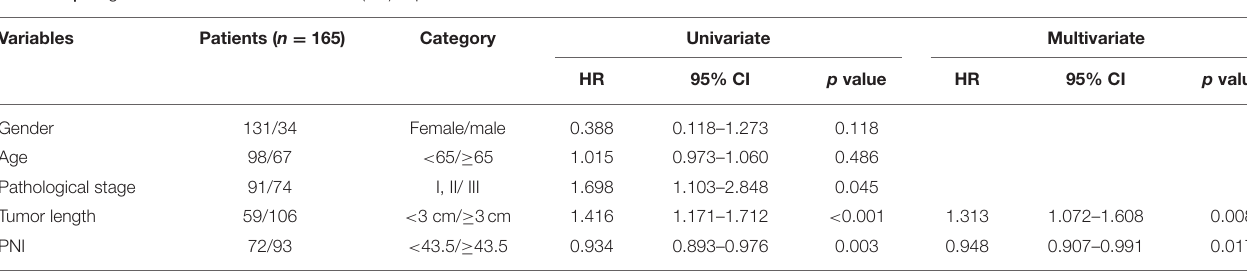
TABLE 2 | Prognostic factors for overall survival (OS) in patients with ESCC. Variables Patients ( n = 165) Category Univariate Multivariate HR 95%